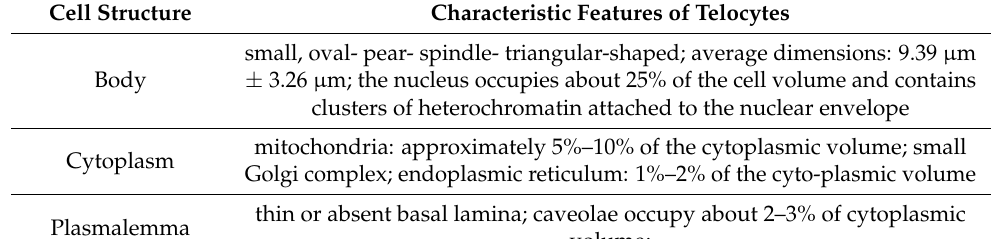
Table 1. Characteristic features of TCs and of their telopodes. Cell Structure Characteristic Features of